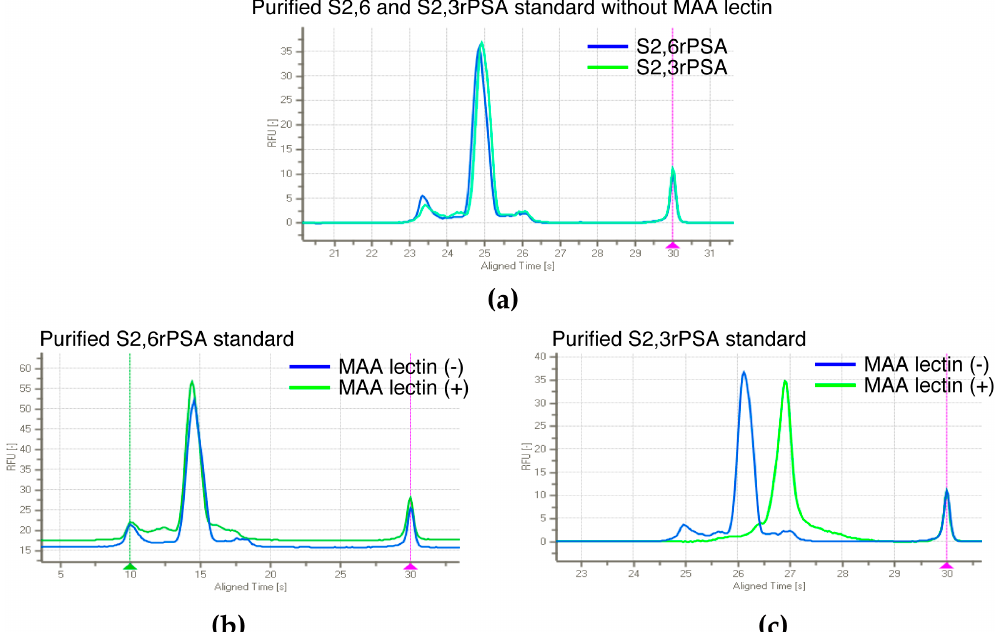
Figure 4. Capture efficiency of applied S2,3PSA standard in μ TAS assay. ( a ) Electropherogram of S2,6rPSA and S2,3rPSA without MAA lectin. S2,6rPSA ( b ) and S2,3rPSA ( c ) standard were applied to the detection of peak separation respectively in a microfluidic channel filled with leading buffer (LB) containing MAA lectin (+) or not ( − ). The capture efficiency was evaluated by the peak mobility shift based on the specific interaction with lectin reactivity.